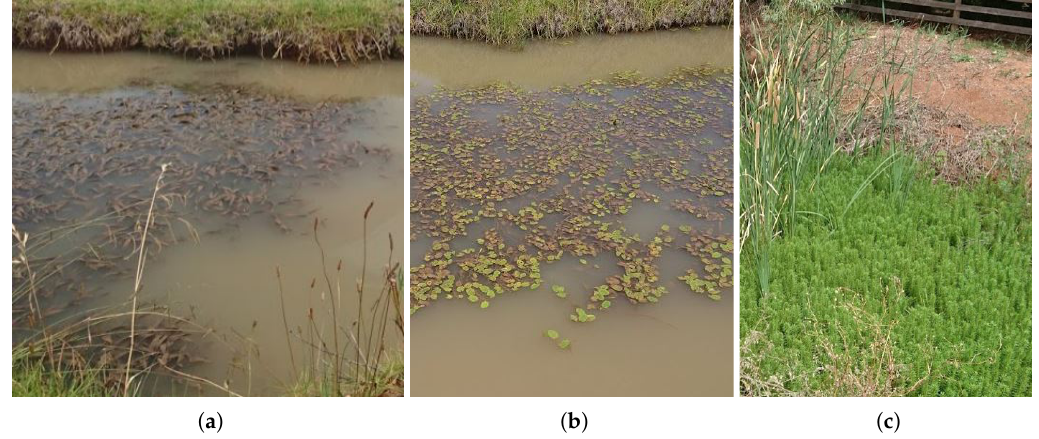
Figure 2. Common weed types in the MIA channels ( a ) Ribbonweed; ( b ) Pondweed; ( c ) Parrot’s feather and cumbungi.